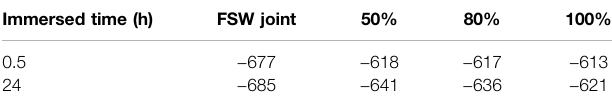
TABLE 2 | OCP of the samples immersed in simulated seawater for 0.5 and 24 h (mV). Immersed time